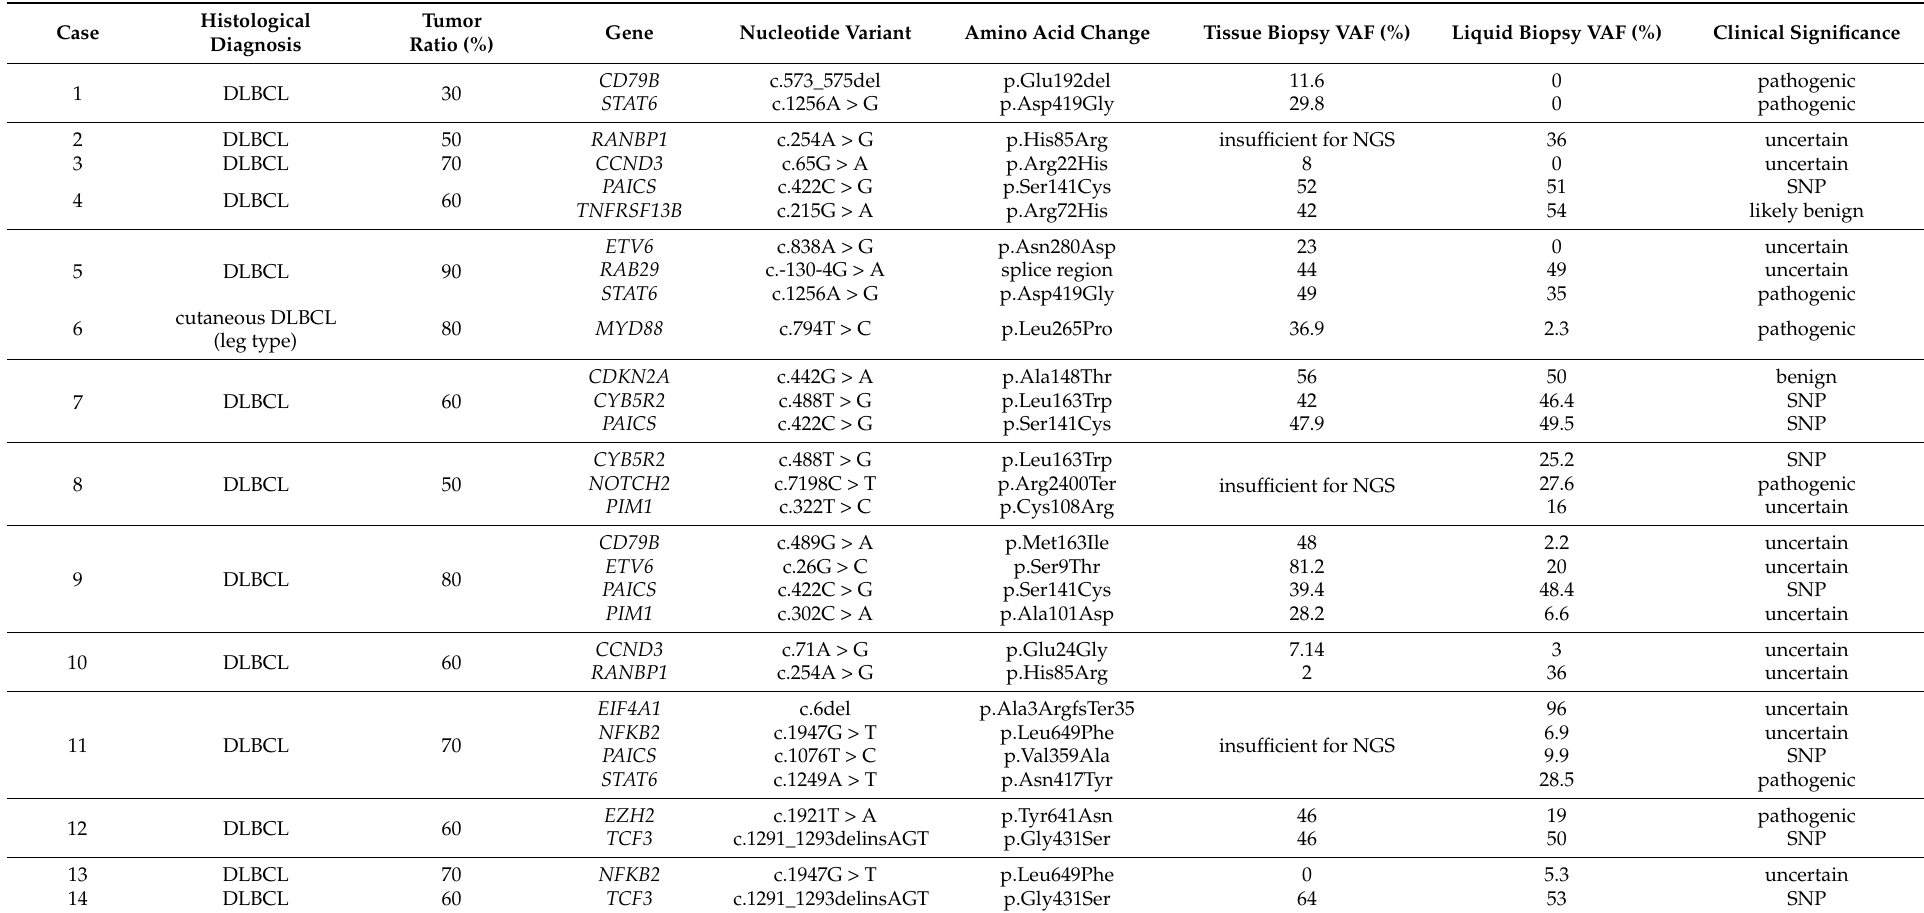
Table 2. Detected gene variants. NGS on samples originating from tissue biopsy and matched liquid biopsy was performed. The number represents the case ID. VAF: variant allele frequency, SNP: single nucleotide